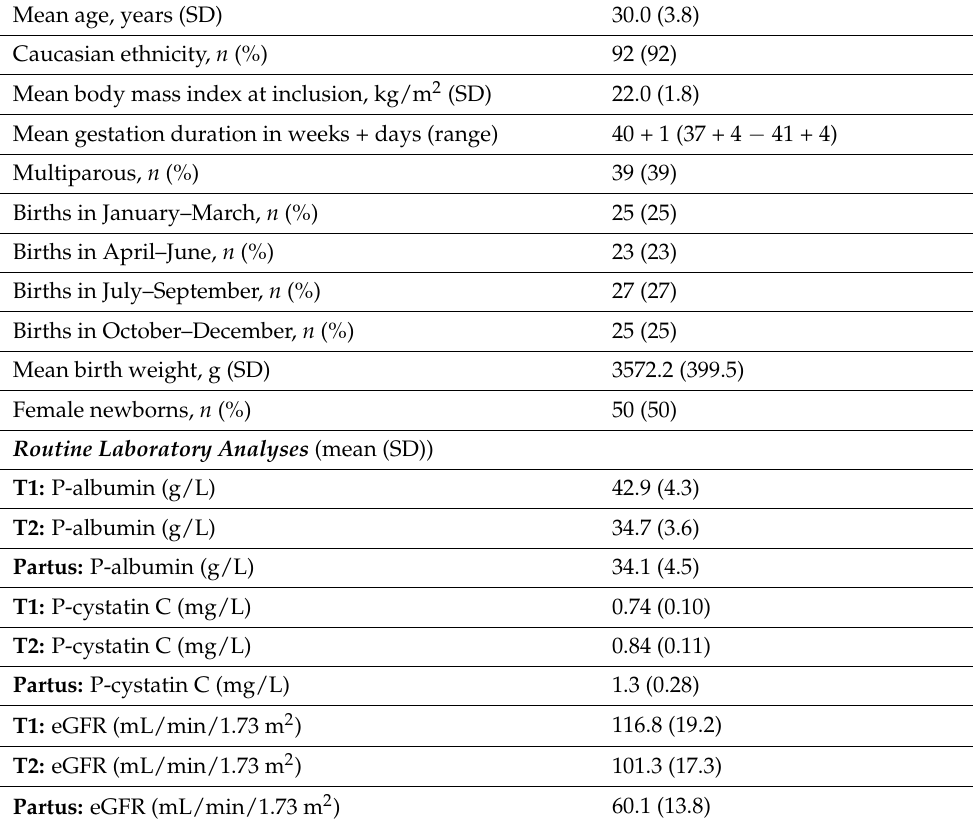
Table 1. Characteristics of the participating women 1 ( n = 100) and their